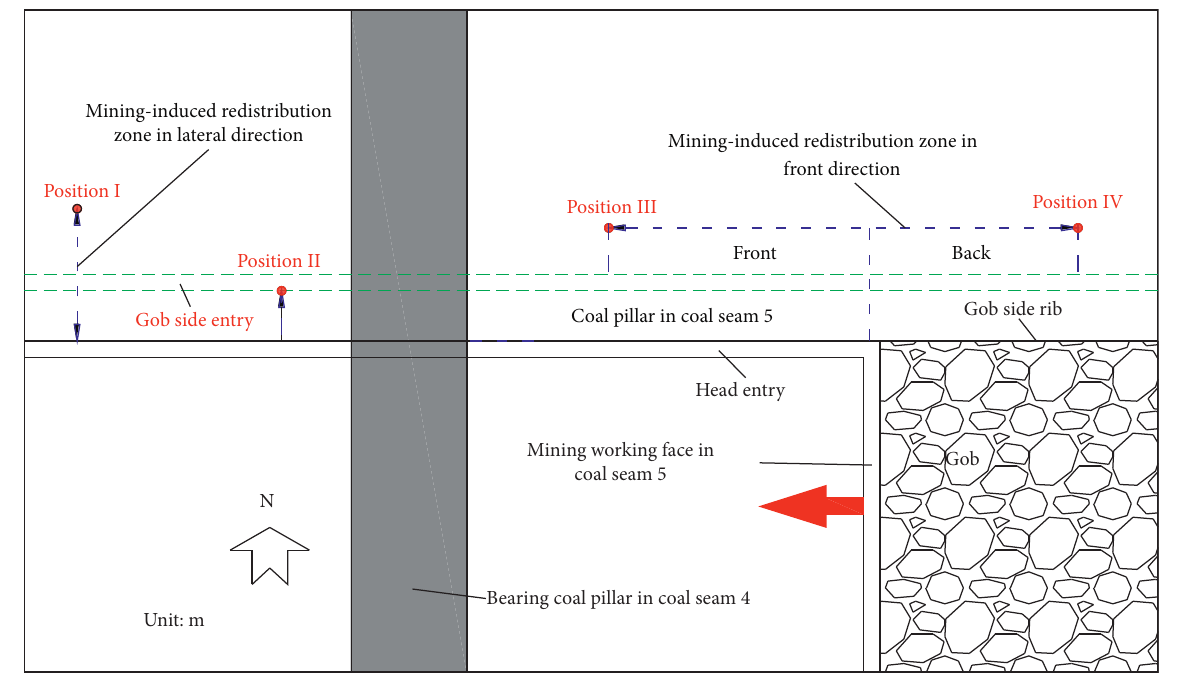
Figure 11: Key parameters to layout the entry under the bearing coal